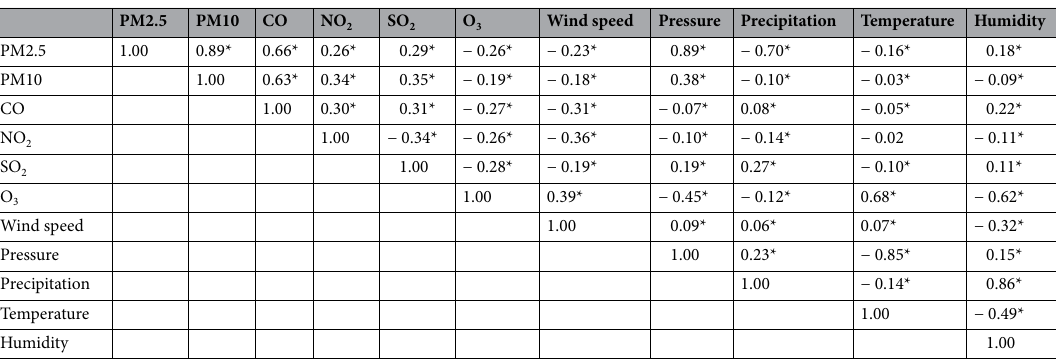
Table 2. Pearson linear correlation coefficients between six types of air pollutant concentrations and climate (band * indicates significant correlation at a significant level of 0.05).